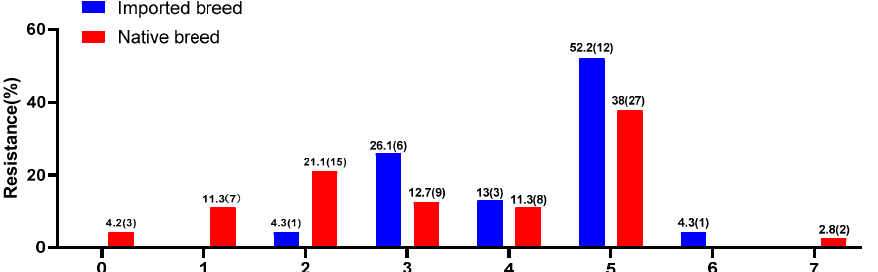
Figure 4. Prevalence of multidrug resistance among 94 Salmonella enterica isolates. 0–7: The number of antimicrobials to which the isolates have resistance; (): The number of isolates with resistance to antimicrobials.